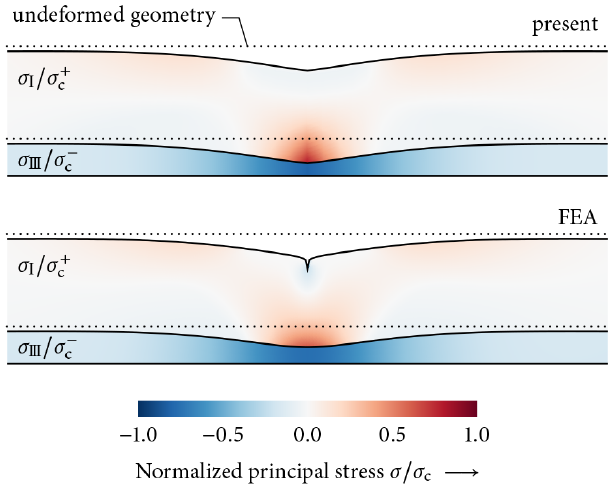
Figure 6. Principal stresses and snowpack deformations scaled 200 times in the central 200cm section of a skier-loaded snow- pack comparing the present model (top) and the FEA reference model (bottom). In the homogeneous slab H, maximum princi- pal normal stresses σ I (tension) normalized to their tensile strength σ + c = 9 . 1kPa are shown. In the weak layer we show minimum prin- cipal normal stresses σ III (compression) normalized to an assumed weak layer compressive strength of σ − c = 2 . 6kPa. The weak-layer thickness is scaled by a factor of 4 for